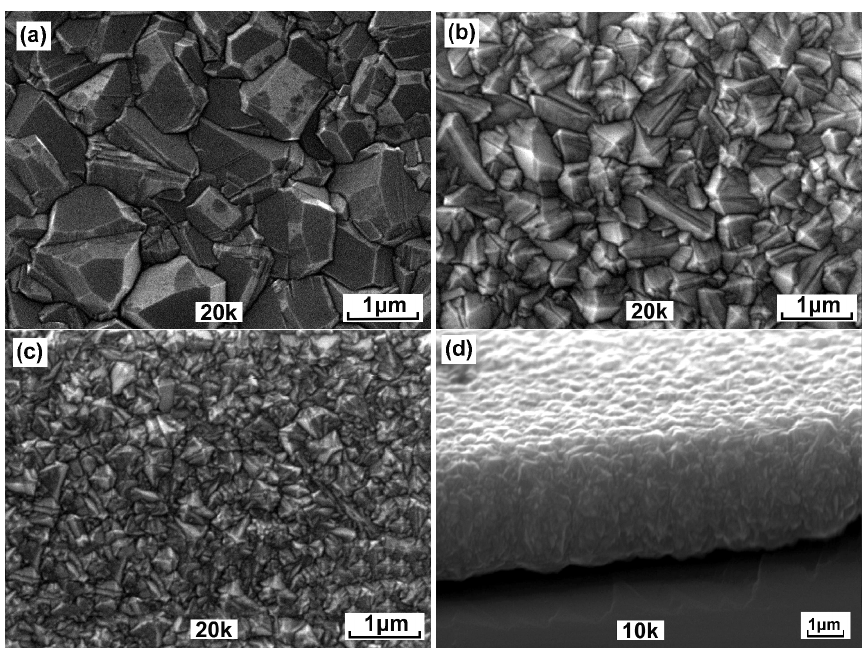
Figure 1. The diamond morphologies synthesized at working gas pressure of ( a ) 40 hPa, ( b ) 60 hPa ( c ) 80 hPa and ( d ) diamond layer cross-section.